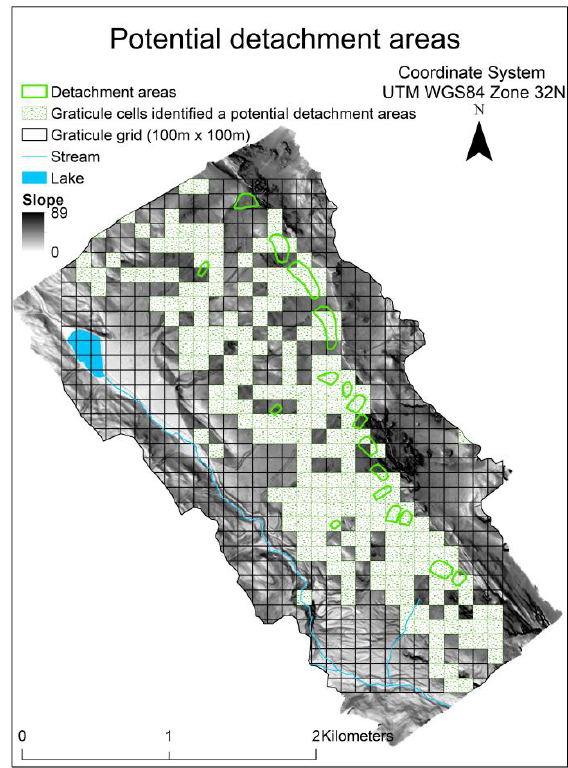
Figure 8. Graticule cells detected as “potential” detachment areas and greatly overestimated. Green polygon are reference detachment areas.